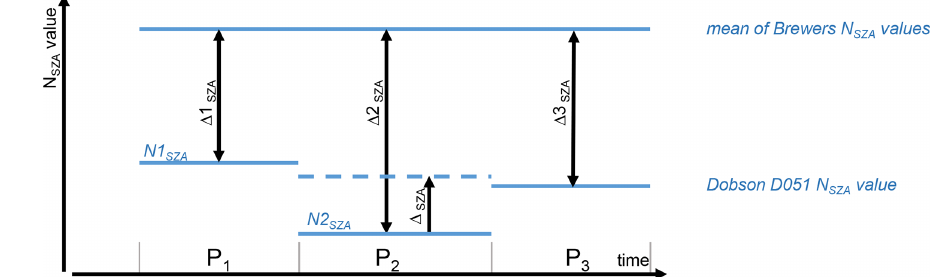
Figure 3. Schematic of the Dobson D051 MCH homogenization